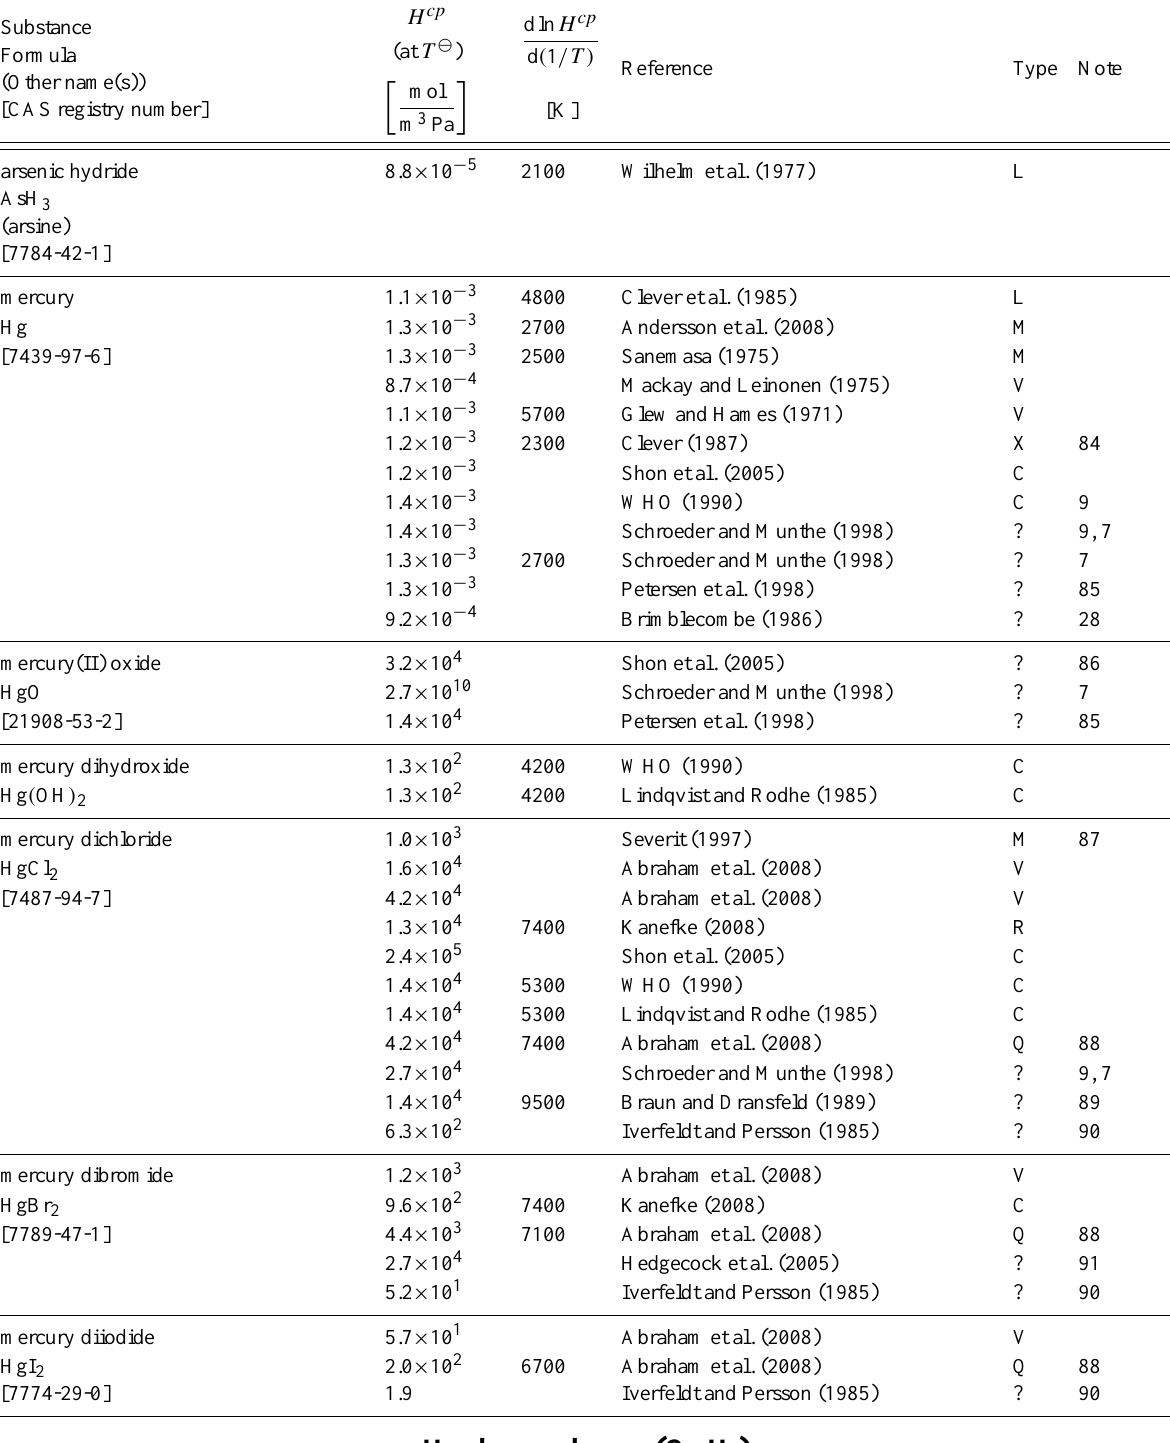
Table 6: Henry’s law constants for water as solvent